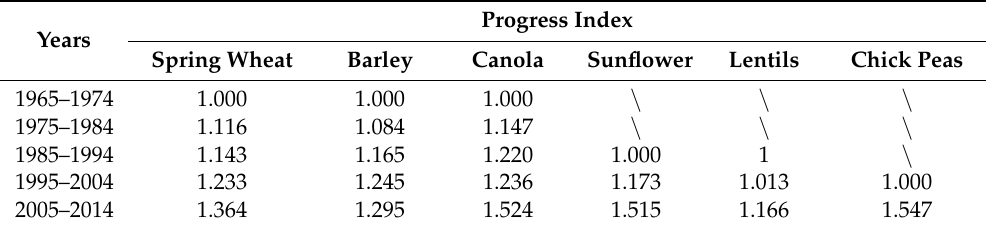
Table 2. Variations of the scientific and technological progress index for a decade divided by the average yield in 1965–2014.